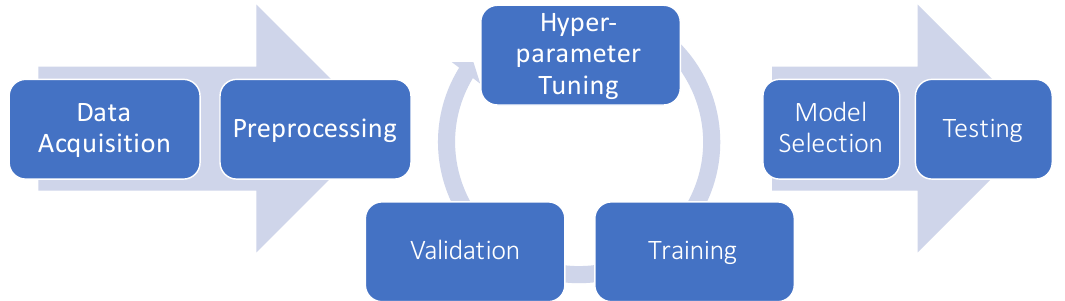
Figure 1. Example of ML pipeline for TGx data. Data Acquisition and Preprocessing: Data is collected and analyzed to ensure the quality of the dataset. During the preprocessing, feature selection and/or feature transformations may be applied to improve stability. Training-Hyperparameter tuning-Validation loop: candidate models are fit to the data. This is embedded in an iterative process where for each candidate model the best hyperparameters are optimized through the validation